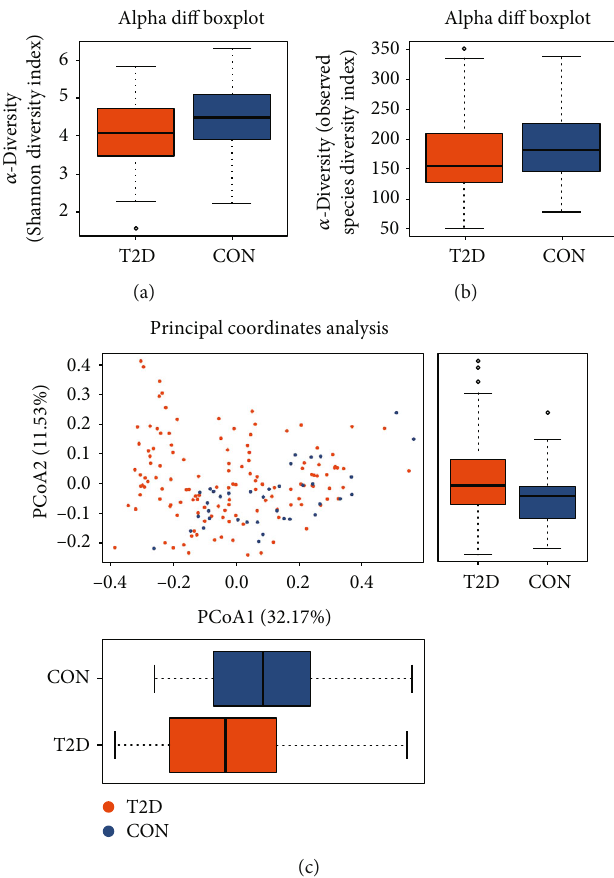
Figure 1: The α -diversity and β -diversity analysis of the T2D and control groups. (a) The Shannon index di ff erence between the T2D and control groups. P = 0 : 009 . (b) The observed species index di ff erence between the T2D and control groups. P = 0 : 040 . The x -axes of both (a) and (b) show the two di ff erent groups. The y -axes show the α -diversity index value. Abnormal values are shown by “ o. ” (c) PCoA of the microbiota between the T2D and control groups. The x -axis represents the fi rst principal coordinate, and the percentage represents the e ff ect on the di ff erence of the two groups. The y -axis represents the second principal coordinate, and the percentage represents the e ff ect on the di ff erence of the two groups. P x = 0 : 001, P y = 0 : 005 . The bottom solid horizontal line represents the minimum value, the lower dotted vertical line represents the fi rst quartile, the center solid horizontal line represents the median, the upper dotted vertical line represents the third quartile, and the top solid horizontal line represents the maximum value. The orange color represents the T2D group. The blue color represents the control group. CON: control group; PCoA: principal coordinates